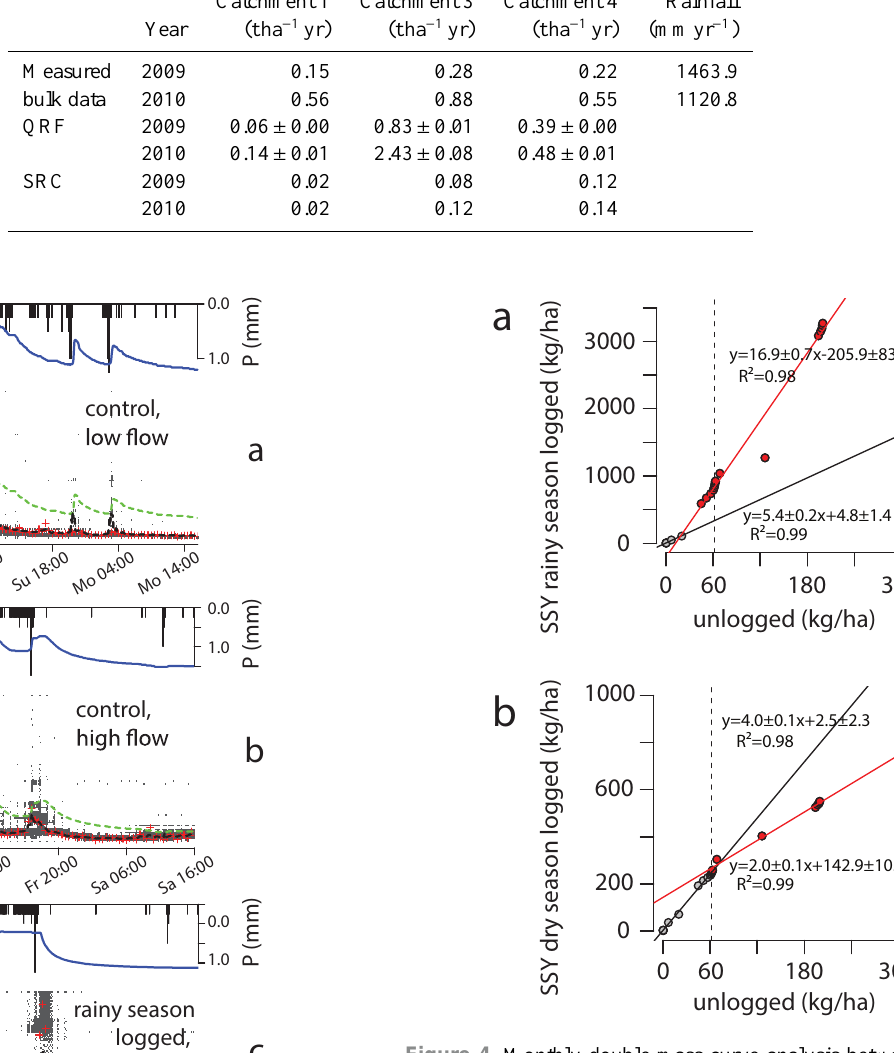
Figure 4. Monthly double-mass-curve analysis between the sedi- ment yields (SSY) of catchments logged during (a) rainy and (b) dry season, and the unlogged control catchment. Black vertical dashed line separates 2009 and 2010 study periods; grey and red circles are pre- and post-logging sediment yields, respectively; lines are best-fit linear regression models. Uncertainties are ± 1 standard